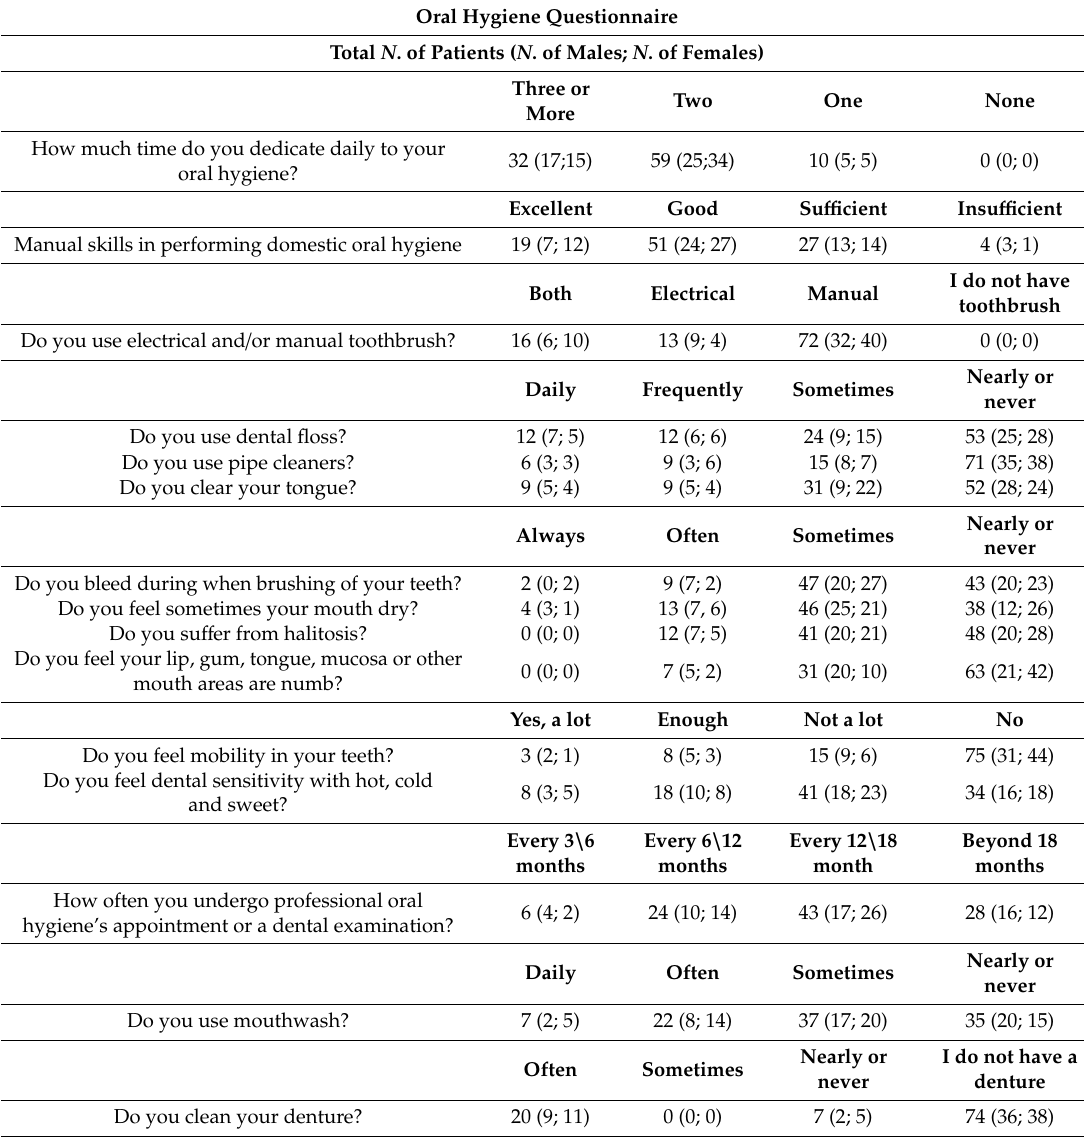
Table 1. Oral Hygiene Habits and Its Quality Questionnaire